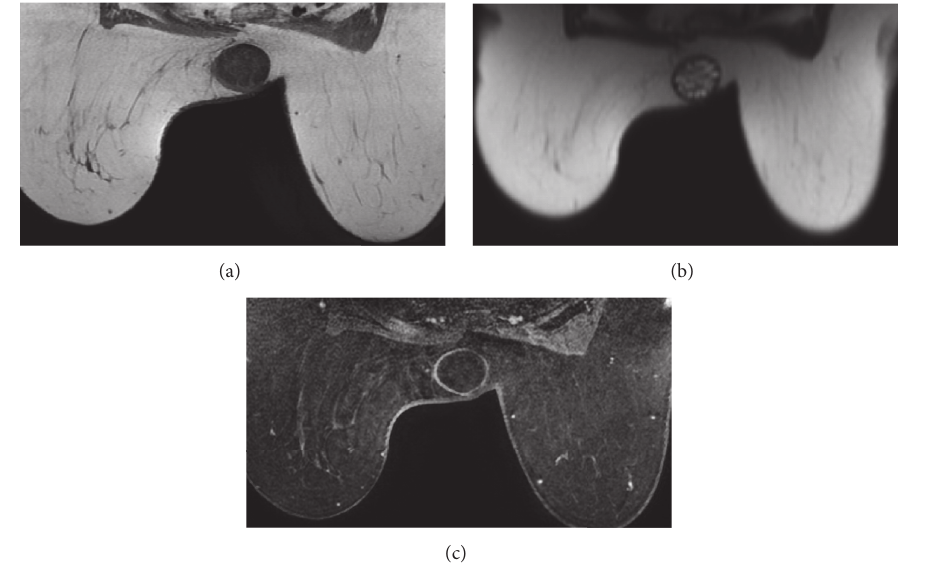
Figure 4: (a) Axial T1- and (b) T2-weighted MR images show that left breast mass with well-defined borders has multiple cystic loculations creating“rosette”pattern.CapsularwallandinternalseptaeofthelesionareisointenseonT1-weightedimageandhypointenseonT2-weighted image; marginally contrast enhancement seen on fat-saturated contrast enhanced T1-weighted image (c).